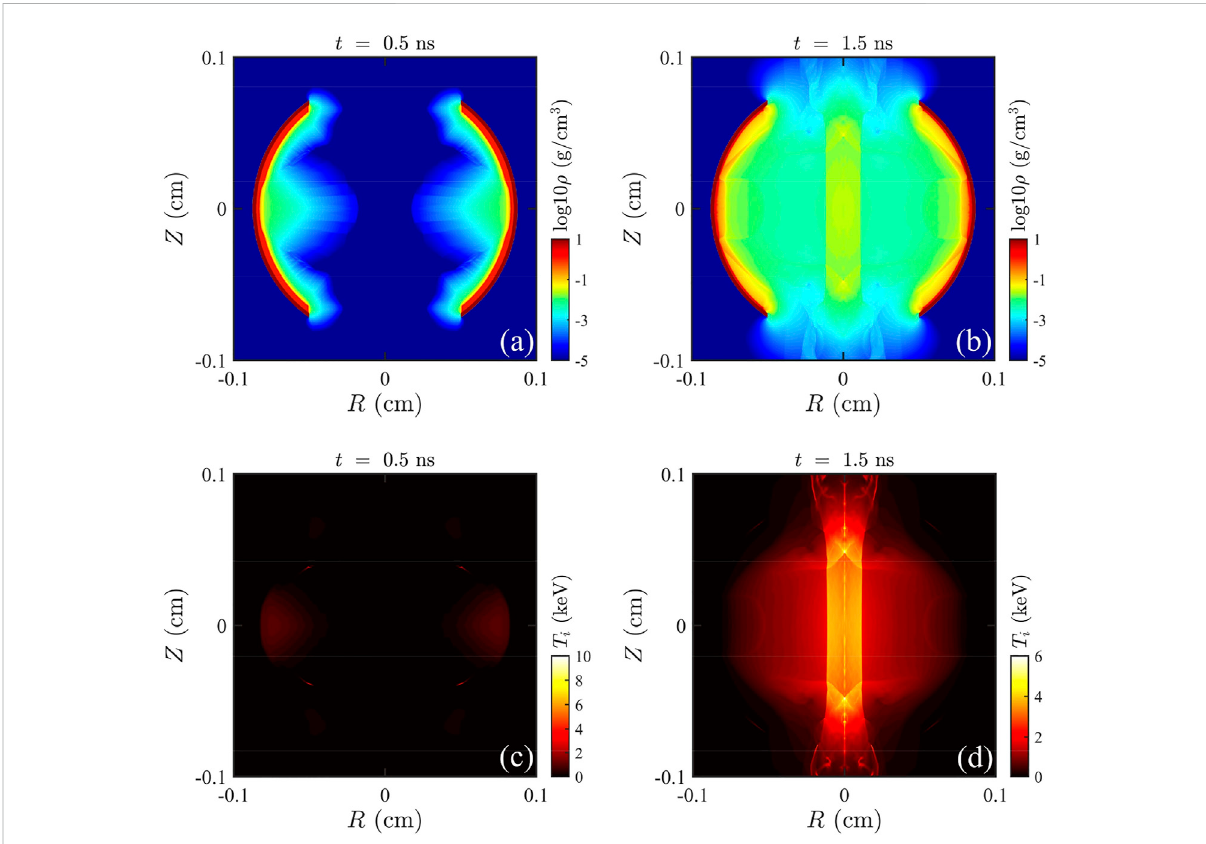
FIGURE 1 Spatial distribution in simulating the SCPF experiments of mass density distribution with color bar of decimal logarithmic scale at 0.5 ns (A) and 1.5 ns (B) . The lower panel (C,D) corresponds to the ion temperature at the same